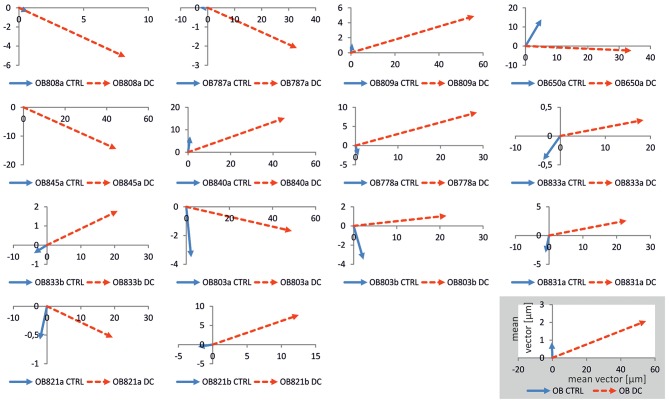
Plots of mean migration vectors for all experiments. Vectors were obtained by averaging migration vectors of all cells (n = 21–42) within one experiment. In all osteoblast cultures obtained from each donor (denoted as OB followed by number and suffix), vectors under control conditions (blue) were shorter than under DC-stimulation (red), and often orthogonal to, or opposing DC-stimulation vectors, the latter of which were all positioned in the right quadrants, i.e., in anodal direction. Distances in the coordinate systems are given in μm. In the inset, the calculated mean vectors for all experiments are given.